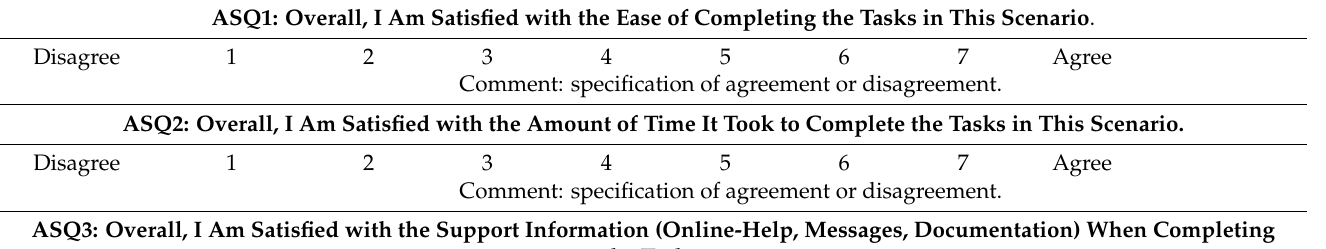
Table 6. Sample questions in the After Scenario Questionnaire (ASQ).